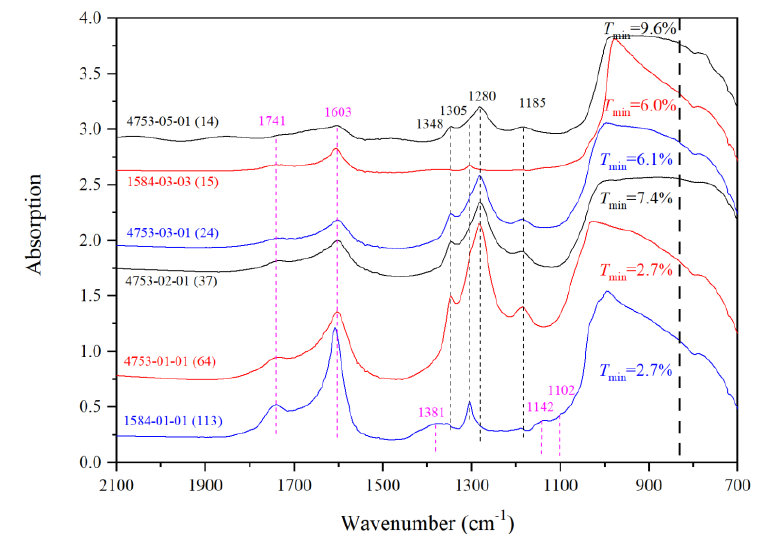
Figure 1. Thickness dependence of the absorptions of the IR peaks in the energy range ~2100–700 cm − 1 . The IR spectra were taken from some thin sections made from high-H 2 O Mg-Rw (Run 4753) and low-H 2 O Mg-Rw (Run 1584). The IR # is followed by the measured thickness of the thin section ( D m in parentheses). T min stands for the minimum percentage of the transmitted light for the segment ~1150–700 cm − 1 . The only expected fundamental at ~830 cm − 1 is denoted by the thick broken line.